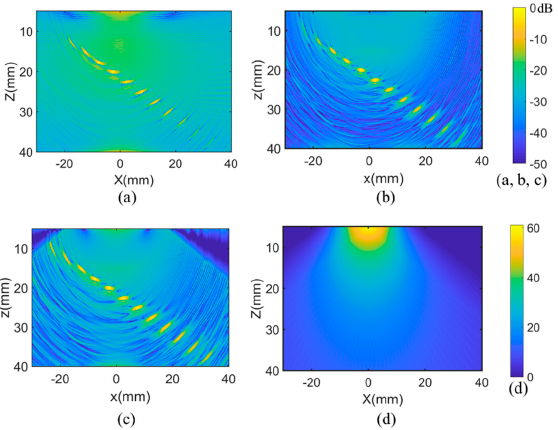
Figure 7. Experimental images obtained by the ( a ) conventional PWI, ( b ) TFM algorithms, and ( c ) optimized PWI with ( d ) space weighting factor. The background noise of the optimized PWI and TFM was about − 30 dB, which is mainly manifested in artifacts caused by the algorithm. The noise of the PWI image was slightly greater than that of the TFM, which was lower than 3 dB on most pixels in the imaging area. At the same time, all defects are well presented in the two images. Note that all the amplitude attenuations of defects in the PWI image were lower than those of TFM, whether the defects were located far away from the array or not. This is consistent with the simulation. Furthermore, the echo dynamic curves of the x and z directions are shown in Figure 8. Amplitude attenuations of defects located away from array display an obvi- ously decline, demonstrating that there is a larger active detection range and higher de- fects amplitude in PWI imaging. In detail, the amplitude attenuation of each defect in the